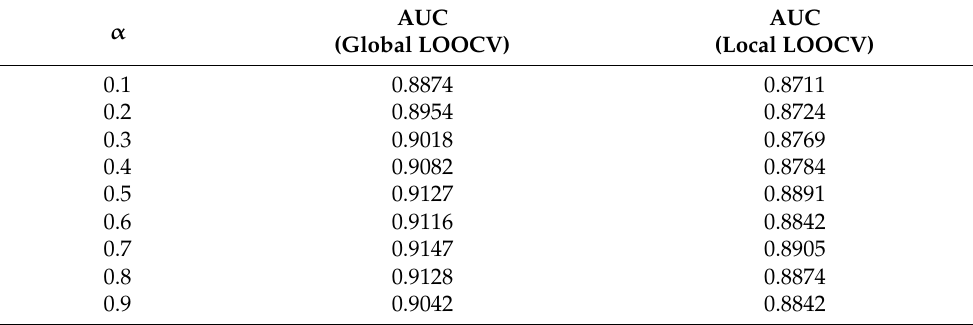
Figure 5. Performance evaluation of MDMF with and without the disease constraint. Application of the disease constraint increased AUC score. Table 4. The effects of disease constraint on the performance of MDMF.